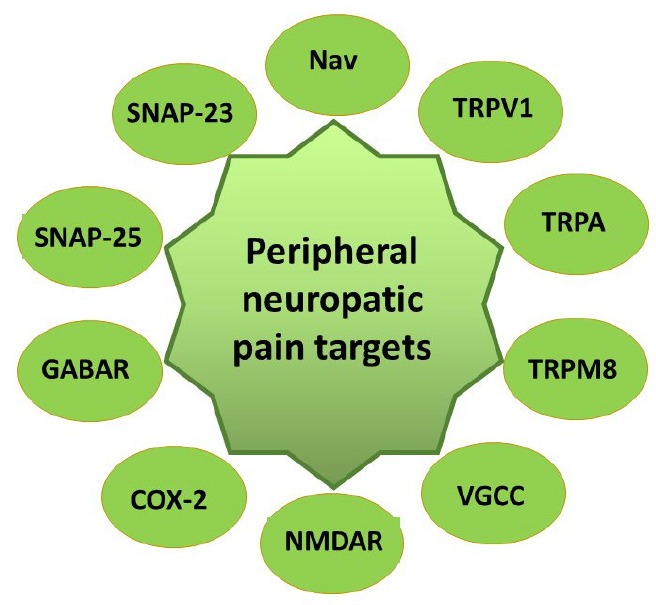
Figure 2. Peripheral neuropathic pain targets (non-opioid). Nav—voltage gated sodium channels, TRPV1—transient receptor potential vanilloid 1 channel, TRPA—transient receptor potential ankyrin channel, TRPM8—transient receptor potential melastatin 8 channels, VGCC—voltage-gated calcium channels, NMDAR—N-methyl-D-aspartic acid receptor, COX-2—cyclooxygenase 2, GABAR—GABA receptor, SNAP-23 and SNAP-25—SNARE protein complex components.